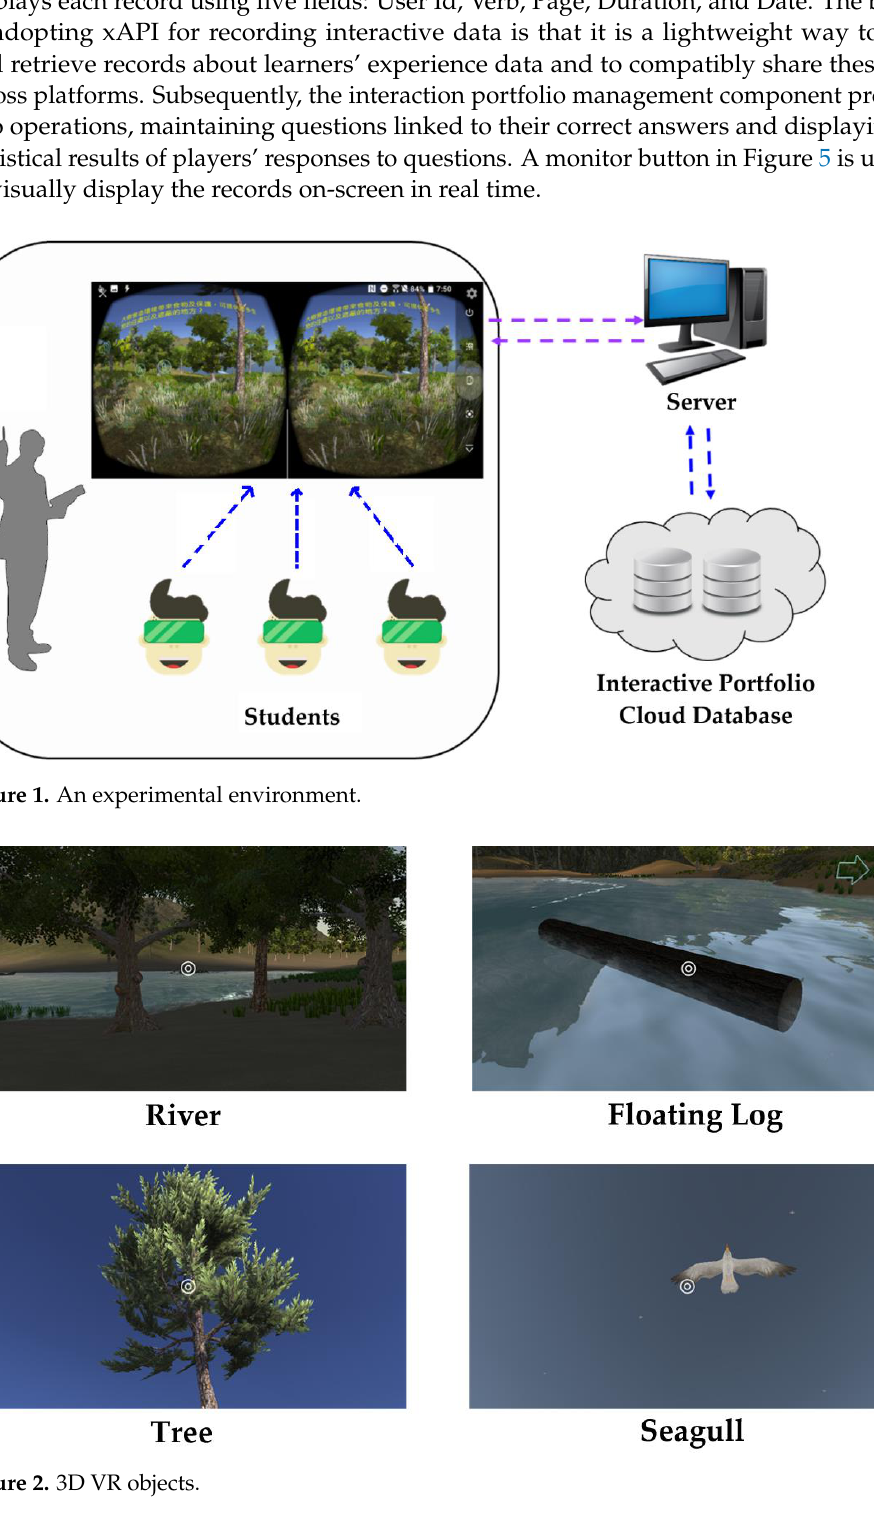
Figure 2. 3D VR objects.